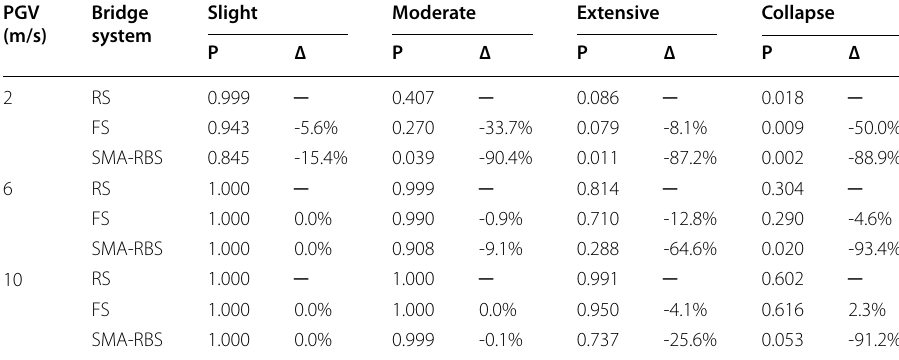
Note: ∆ is the relative difference between the rigid system (RS) and two other bridge systems